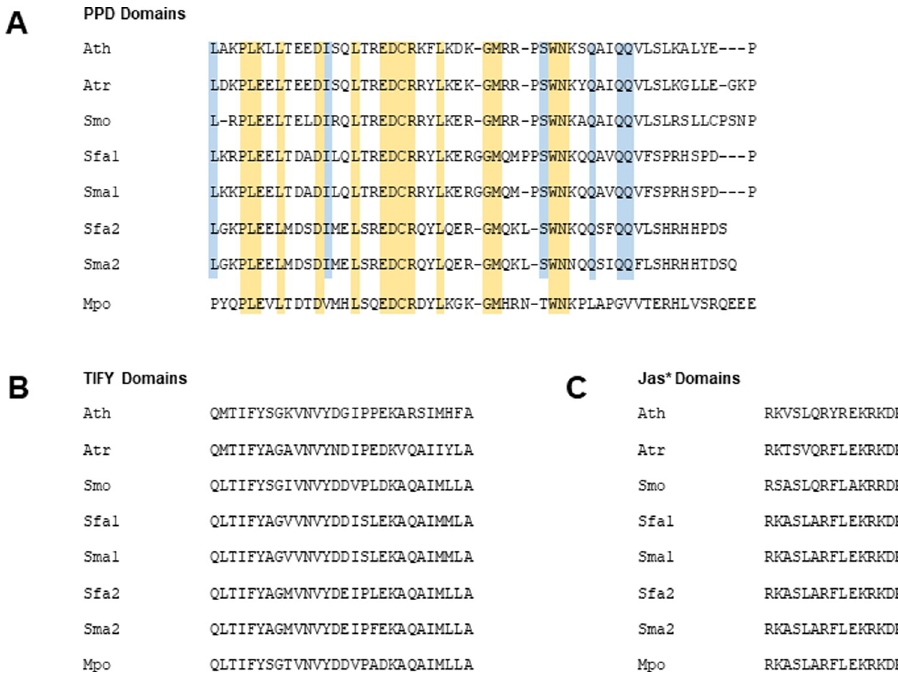
Fig 8. Alignment of PPD, TIFY and Jas � domains of Arabidopsis thaliana (Ath), Amborella trichopoda (Atr), Selaginella moellendorffii (Smo), Sphagnum fallax (Sfa), Sphagnum magellanicum (Sma) and Marchantia polymorpha (Mpo). A. Over the PPD domain, M . polymorpha is the most divergent sequence from Arabidopsis, with residues conserved in all sequences shown in yellow and residues conserved in all sequences except M . polymorpha shown in blue. B. The aligned TIFY domains. C. The aligned Jas � domains.